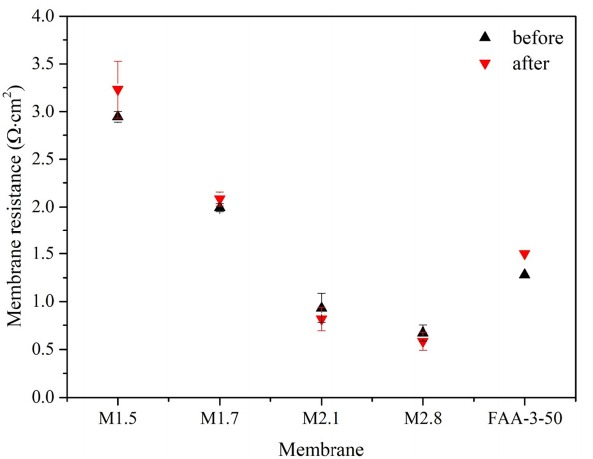
Figure 9. Membrane resistance of the four prepared AEMs and commercial membrane FAA-3-50